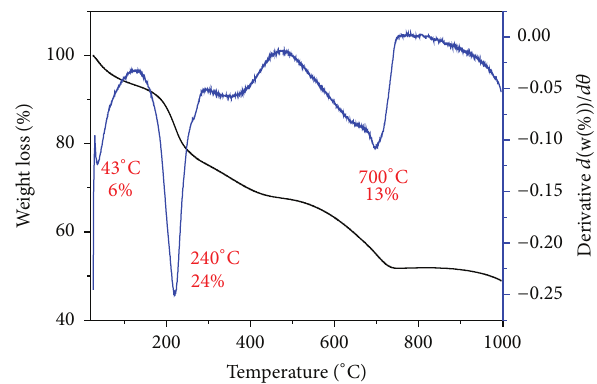
Figure 4: Thermogravimetric analysis-differential thermogravi- metric thermograms of PAS-ZLH